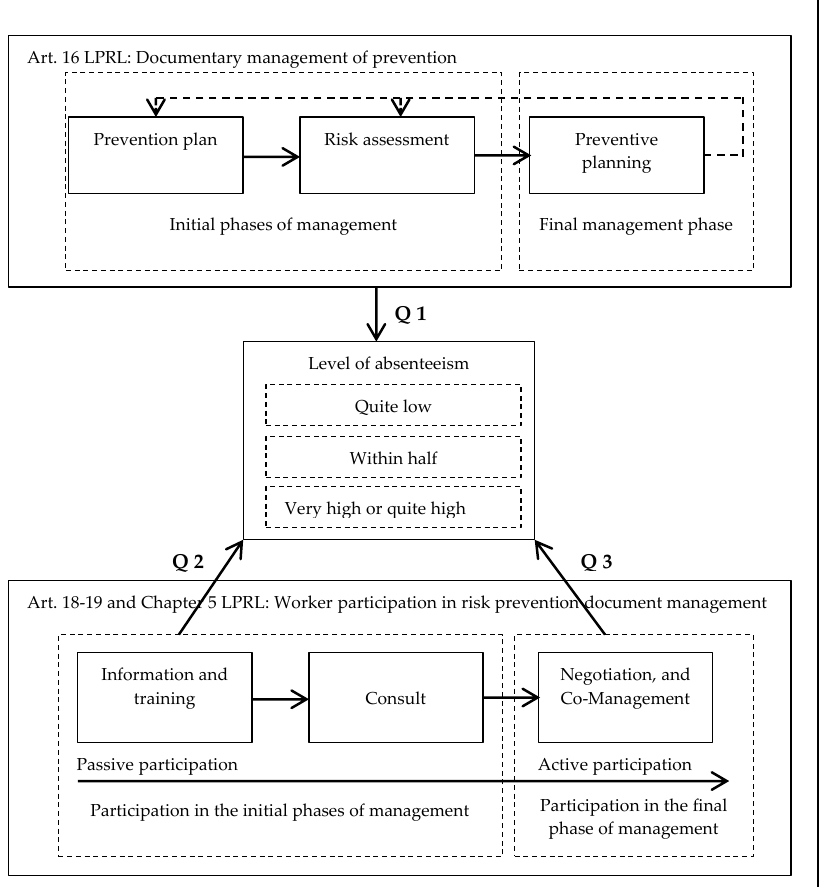
Figure 1. Participatory management system for the prevention of occupational risks. Q1: first research question; Q2: second research question; Q3: third research question; Art. 16: article 16 of the law